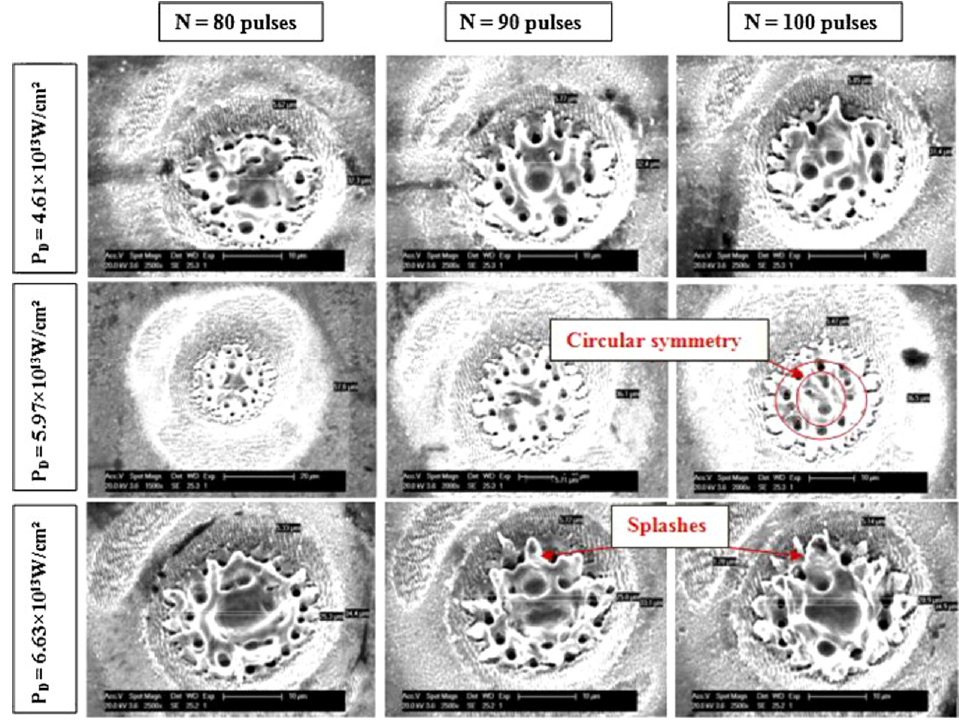
Figure 7. Porous and splashlike structures on X40Cr14. “Reprinted with permission from Ref. [36], Copyright (2013), Elsevier”.